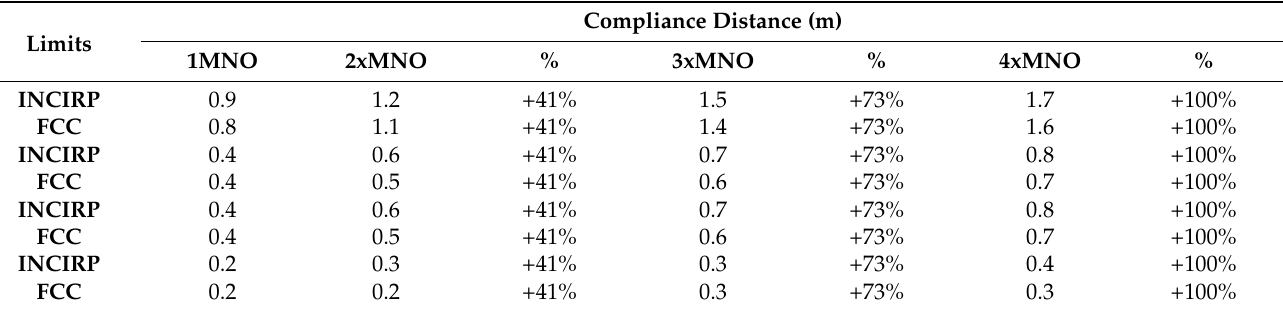
Table 5. DC for IBS site shared by up to 4 MNOs, referencing the ICNIRP and FCC limits.